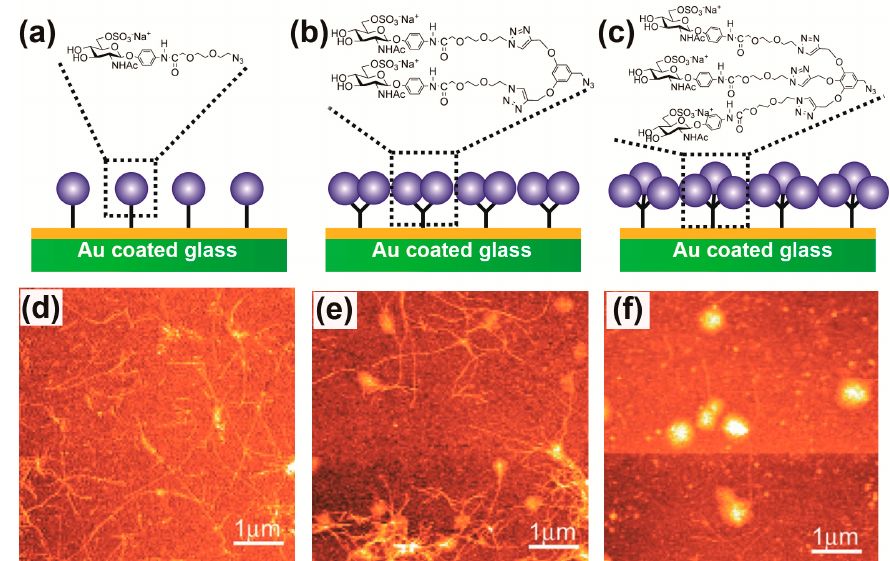
Figure 8. Illustrations of the mono- ( a ), di- ( b ) and tri- ( c ) valent 6-sulfo- N -acetyl- D -glucosamine modified glass substrates with gold coating. Morphology observed by AFM on the monovalent ( d ) divalent and ( e ) trivalent ( f ) glycoclusters modified surfaces after they were incubated in a A β (1–42) solution (10 μ M) for 12 h at 25 °C. These results indicate that A β (1–42) tends to form fibril-like aggregates on the monovalent glycocluster-modified surface, while on the multivalent glycocluster-modified surface, A β (1–42) tends to form globular aggregates [109]. ( a – f ) Adapted with permission. Copyright 2010, ACS.